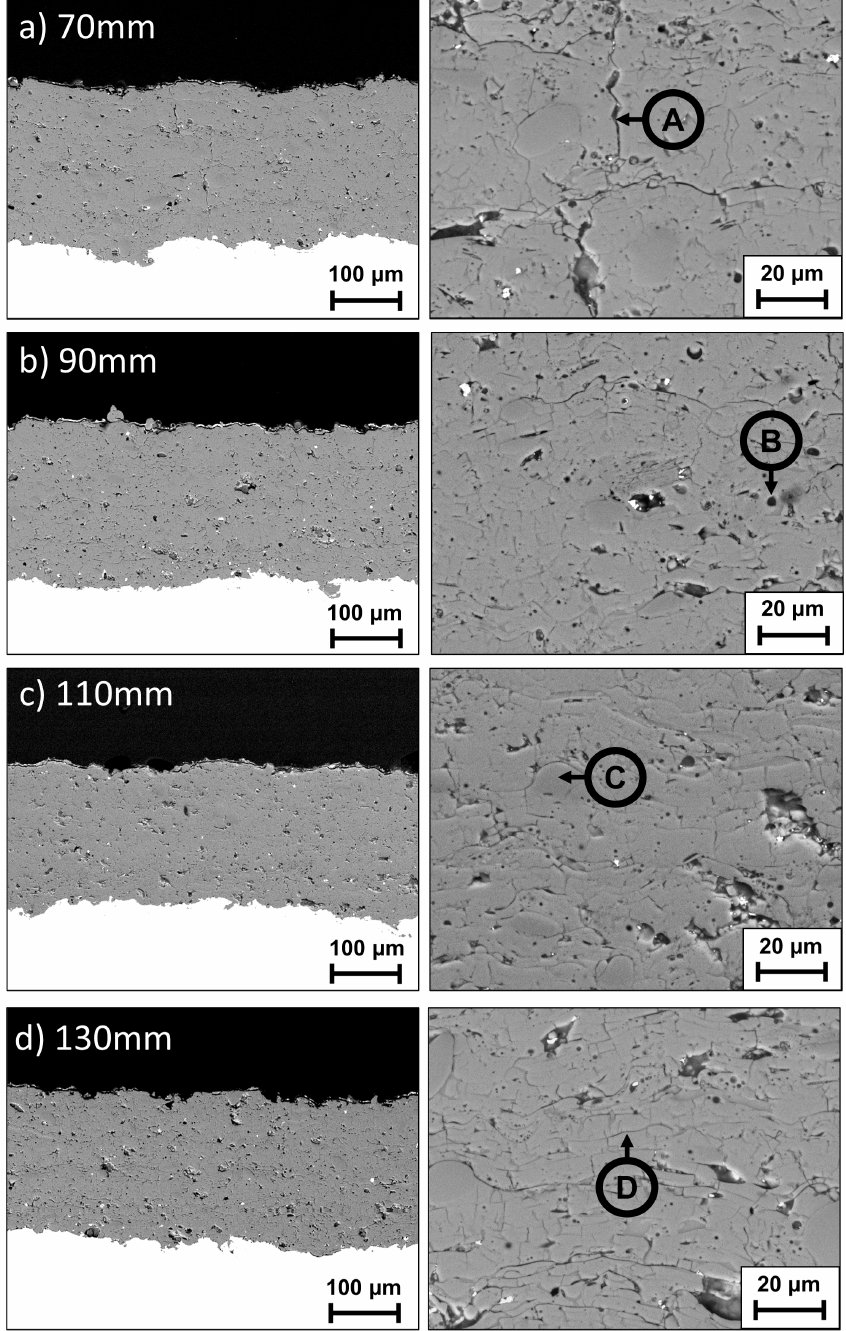
Figure 2. SEM micrographs of the sample’s cross-section (magnification 200 × and 1000 × ). The spray distance is depicted in the following order—( a ) 70 mm; ( b ) 90 mm; ( c ) 110 mm; ( d ) 130 mm. A—macro-crack; B—pore; C—unmolten particle; D—splat